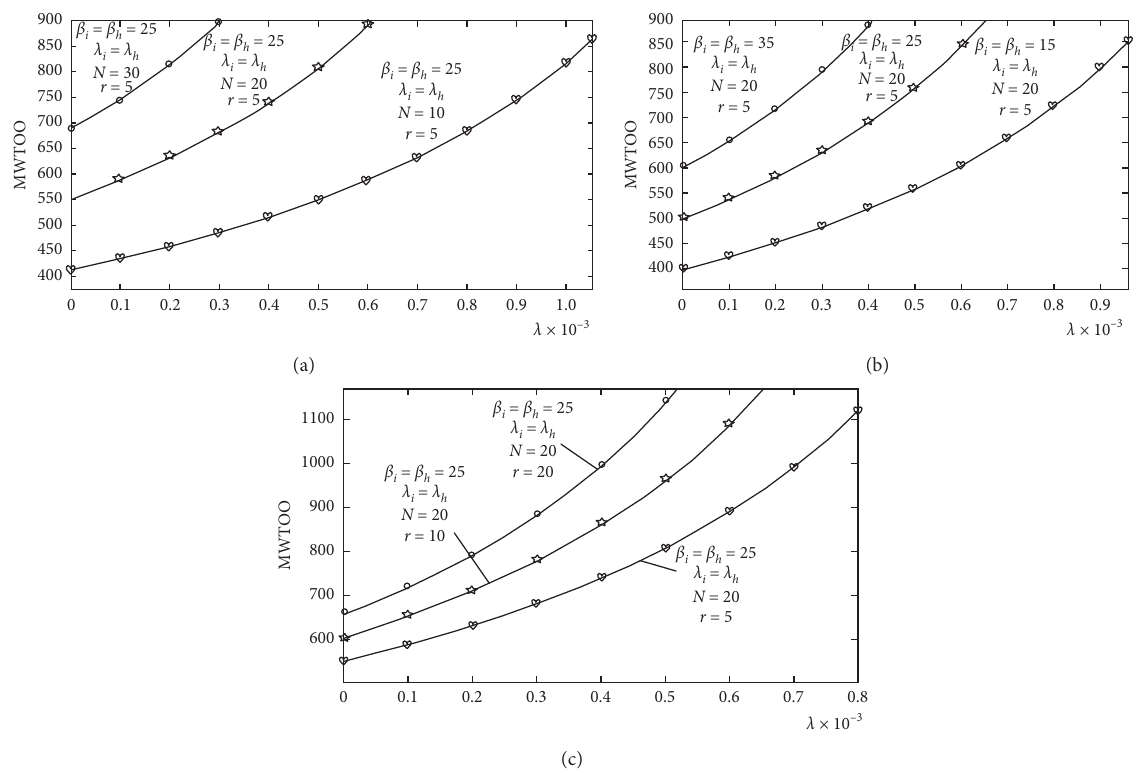
Figure 6: The change trend of MWTOO. (a) Range of MWTOO with λ ′ s change under different N. (b) Range of MWTOO with λ ′ s change under different β. (c) Range of MWTOO with λ ′ s change under different r